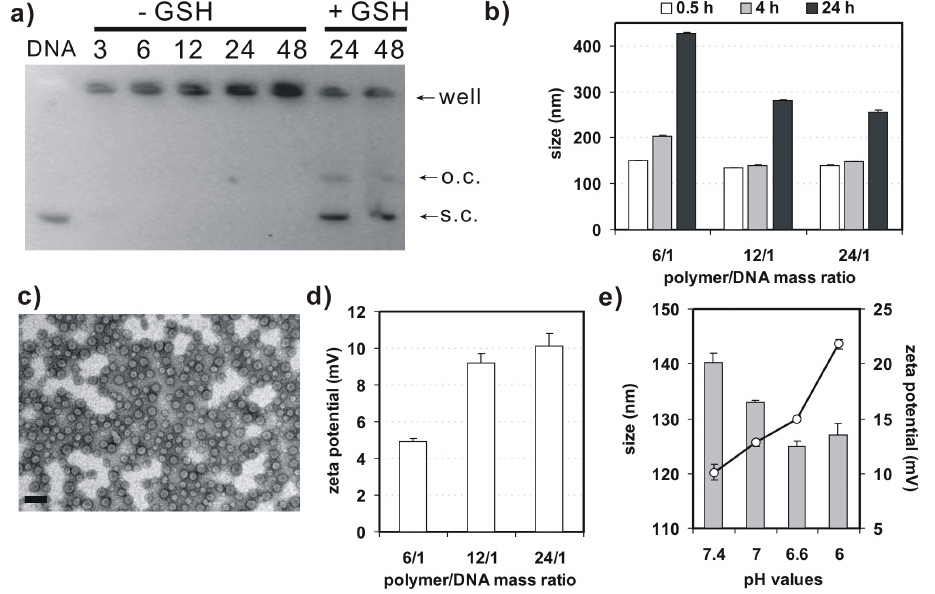
Figure 3. ( a ) Argarose gel retardation assay on binding behavior of 4-arm PEG-SSPHIS and plasmid DNA with (-GSH) or without (+GSH) of glutathione (GSH); ( b ) Particle size of the polyplexes of 4-arm PEG-SSPHIS at different polymer/DNA ratios as a function of incubation time in the presence of 130 mM NaCl; ( c ) Typical TEM image of polyplexes of 4-arm PEG-SSPHIS at the mass ratio of 12/1 (scale bar: 100 nm); ( d ) Zeta potential of the polyplexes of 4-arm PEG-SSPHIS at different polymer/DNA ratios; ( e ) Effect of pH values on size and zeta potential of the polyplexes of 4-arm PEG-SSPHIS at the mass ratio of